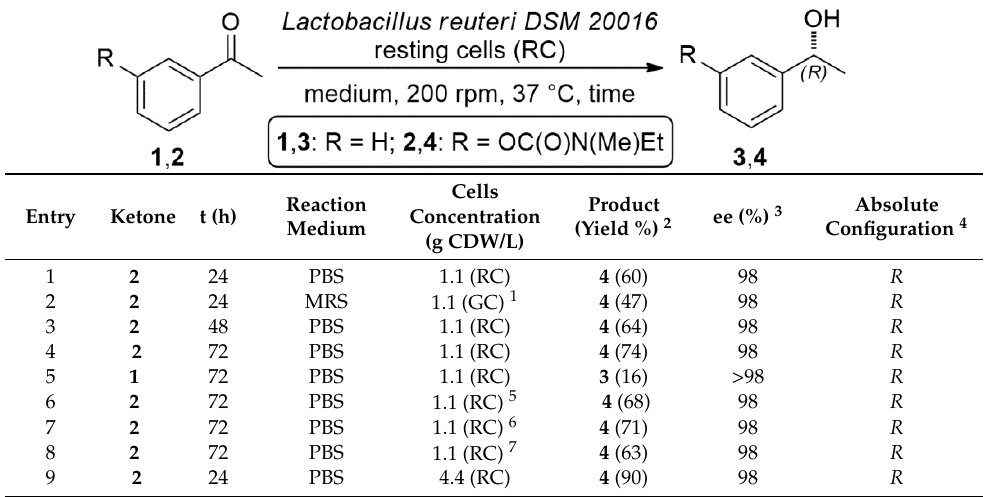
Table 2. Stereoselective reduction of ketones 1 and 2 with Lactobacillus reuteri DSM 20016 whole cells 1 . CDW: cell dry weight.